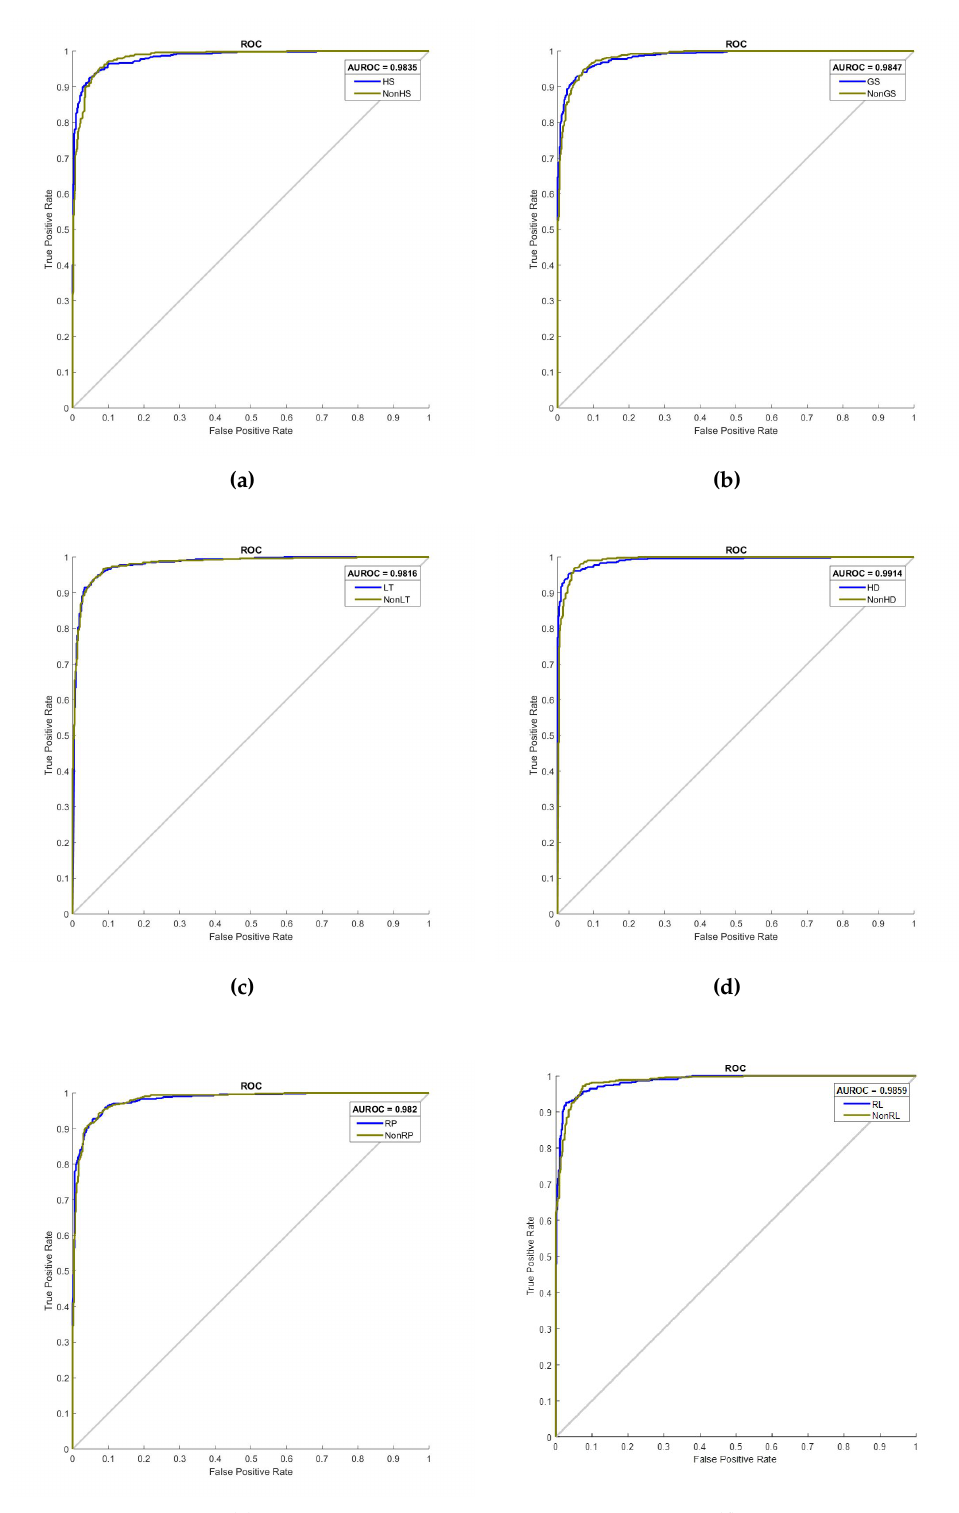
Figure 11. Receiver operating characteristic (ROC) curves for classification of six motor events, ( a ) HS, ( b ) GS, ( c ) LT, ( d ) HD, ( e ) RP, and ( f ) RL tested in the framework of